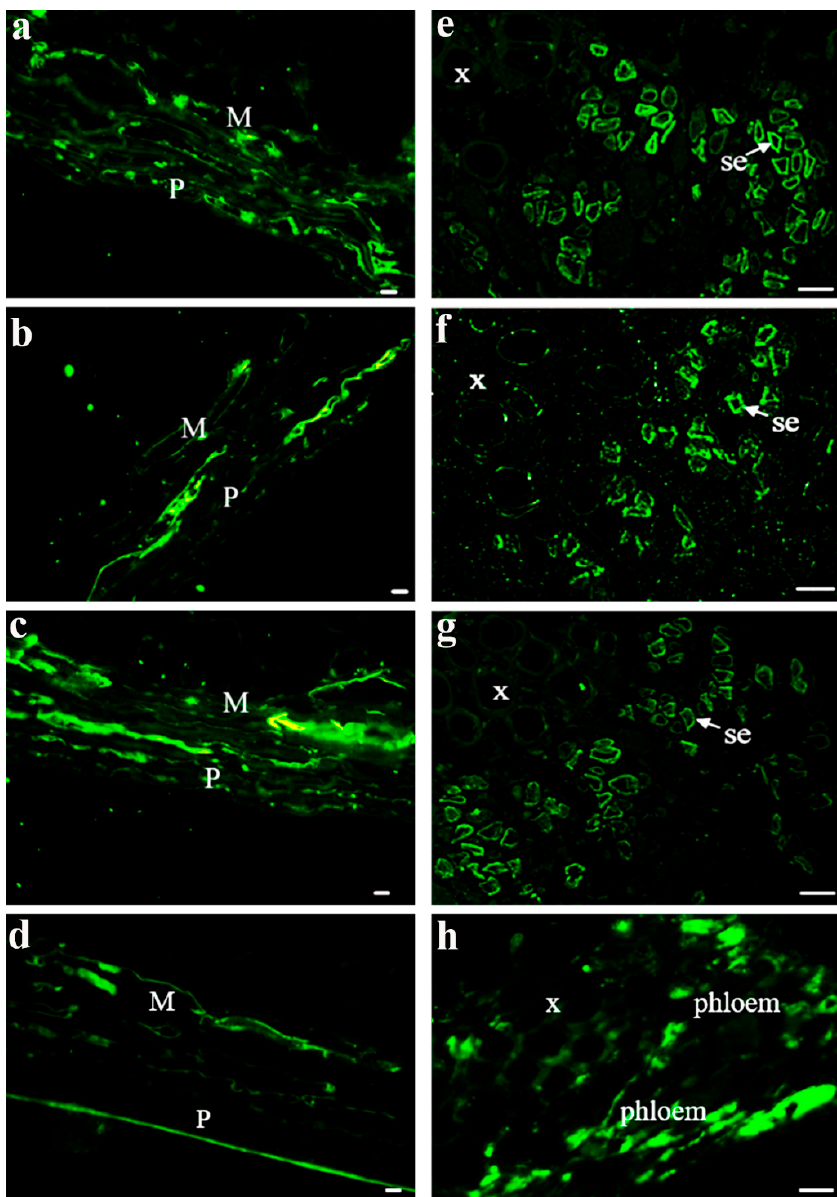
Figure 3 . Immunolocalization of VvSUC11, VvSUC12, and VvSUC27 in the Chardonnay berry. ( a ) to ( d ): pericarp and mesocarp cell immunolocalization of VvSUC11, VvSUC12, VvSUC27, and β - tubulin in the Chardonnay berry. P: pericarp; M: mesocarp. Bars = 10 μ m. ( e ) to ( h ): central vascular bundle cell immunolocalization of VvSUC11, VvSUC12, VvSUC27, and β -tubulin in the Chardonnay berry. x: xylem; se: sieve element. Bars = 10 μ m.